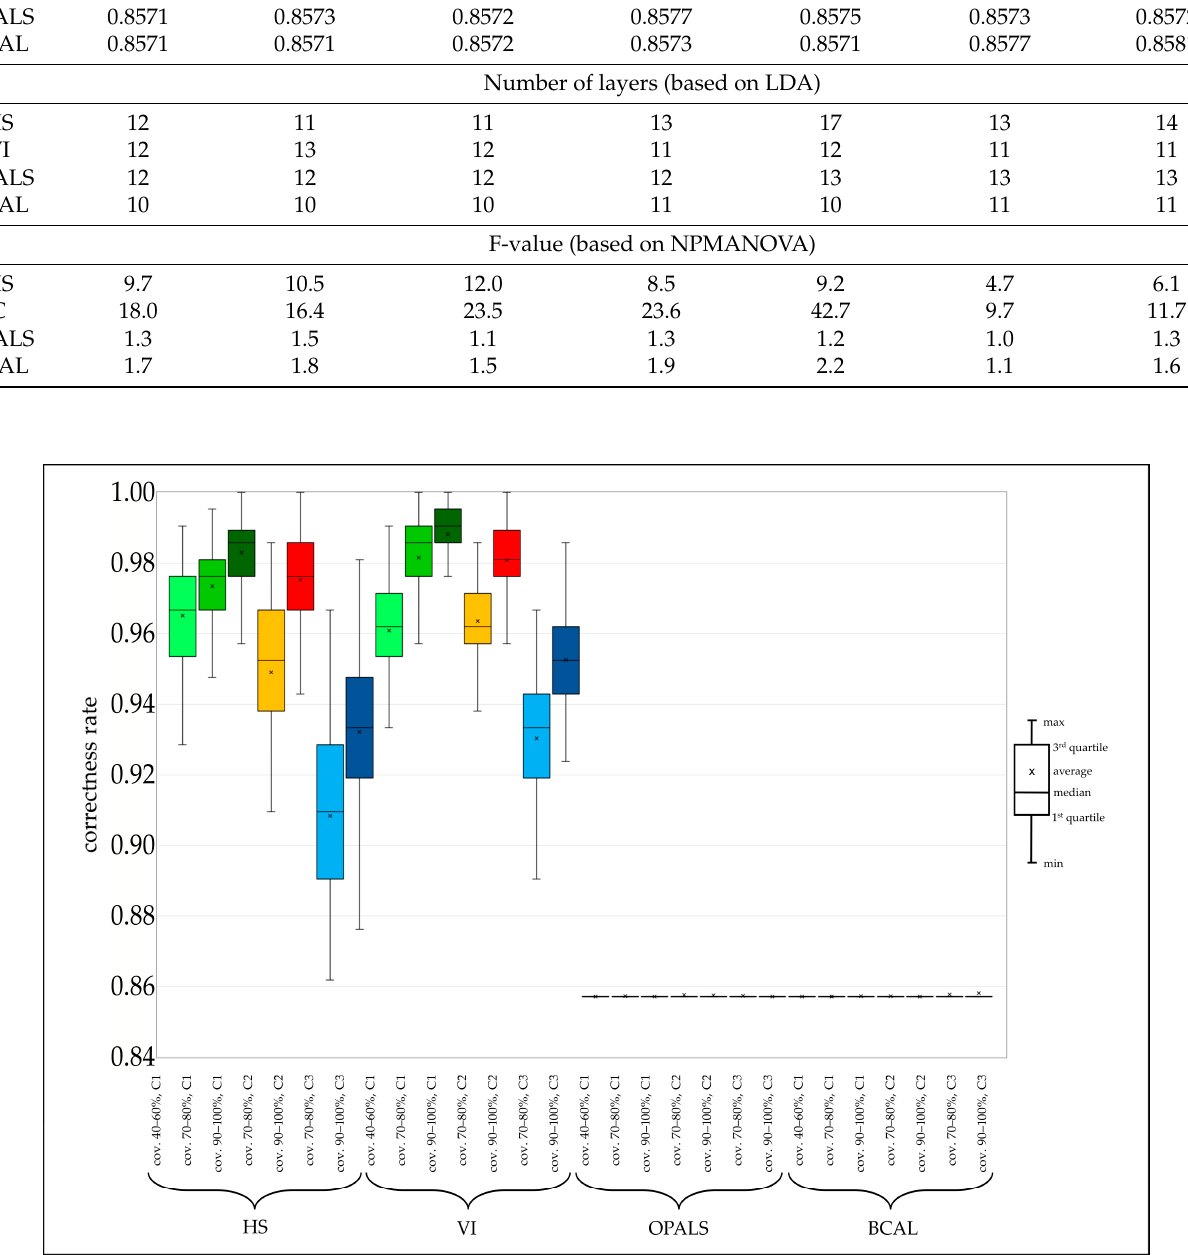
Figure 4. Values of the correctness rate based on 100 iterations for different